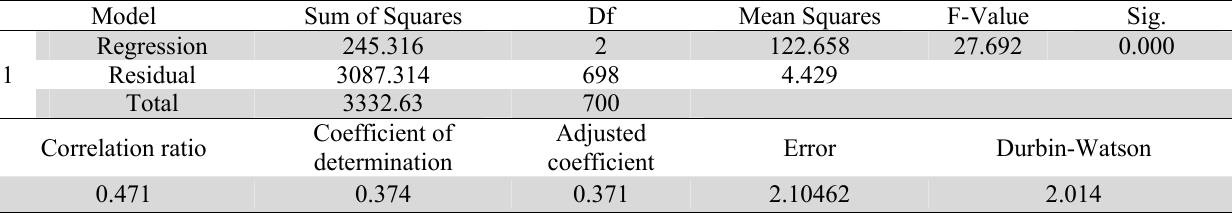
Model Sum of Squares